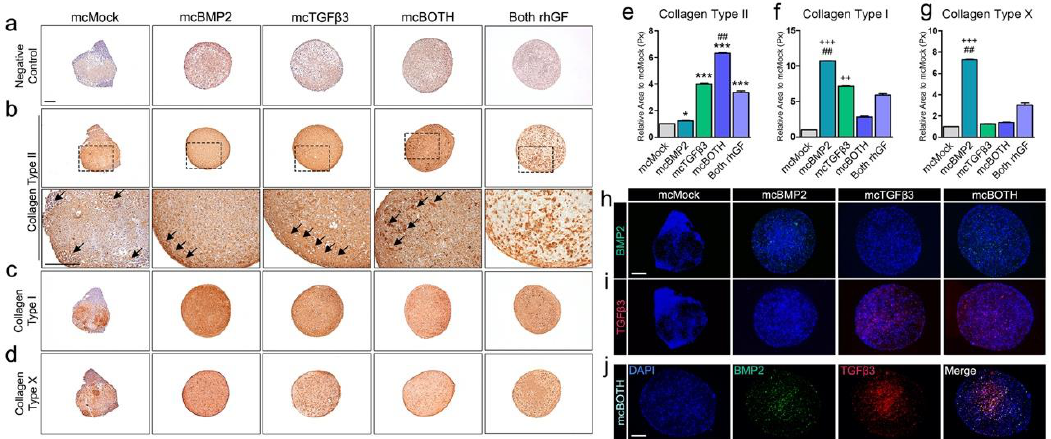
Figure 4. Further characterization of chondrogenic pellets generated with minicircles. ( a ) Image of antibody-negative control pellets used in immunohistology. ( b ) Image of pellets stained with collagen type II. The upper panel shows the 5x magnification image of each pellet and the lower panel shows the 200 × magnification image. ( c ) Image of pellets stained with collagen type I. ( d ) Image of pellets stained with collagen type X. Quantification data of ( e ) collagen type II, ( f ) collagen type I, and ( g ) collagen type X. ( h ) Fluorescence image of pellets stained with the BMP2 antibody. ( i ) Fluorescence image of pellets stained with the TGF β 3 antibody. ( j ) Double staining image of the mcBOTH pellet. All scale bars represent 200 µ m. * p < 0.05; ** p < 0.01; *** p < 0.001 vs. mcMock, ++ p < 0.01; +++ p < 0.001 vs. Both rhGF (t-test), ## p < 0.01 vs. mcMock (one-way Anova) indicate significance. mcMock: minicircle mock vector-transfected outgrowth cells; mcBMP2: minicircle BMP2-encoding vector-transfected outgrowth cells; mcTGF β 3: minicircle TGF β 3-encoding vector-transfected outgrowth cells; mcBOTH: 1:1 mixture of the mcBMP2- and mcTGF β 3-transfected outgrowth cells.